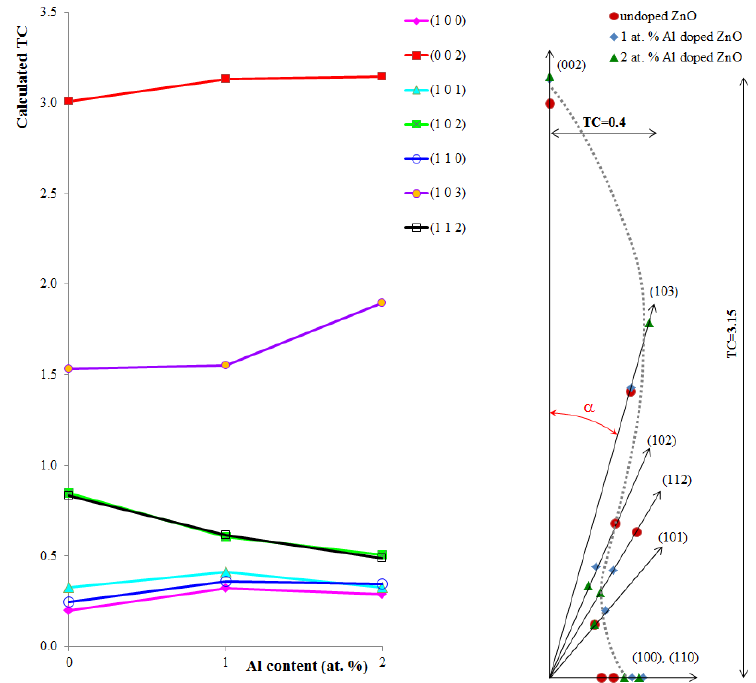
Figure 2. Texture Coefficients of 7-layer ZnO thin films calculated from the XRD patterns presented in Figure 1. Left : Texture coefficient (TC) values of the 7 main peaks of the diffraction pattern as a function of Al-doping content; Right : TC values represented in polar coordinates as a function of the α angle between the considered reflection and the (002)